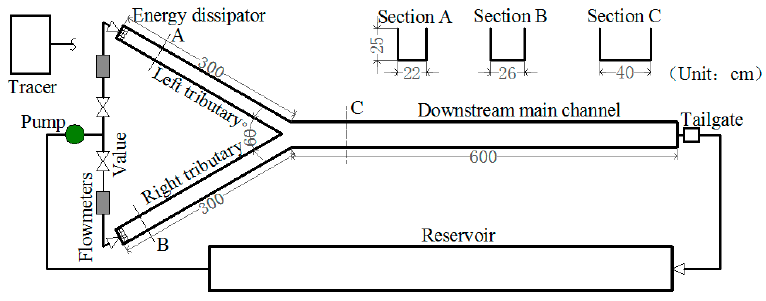
Figure 3. Schematic diagram of the flume model.